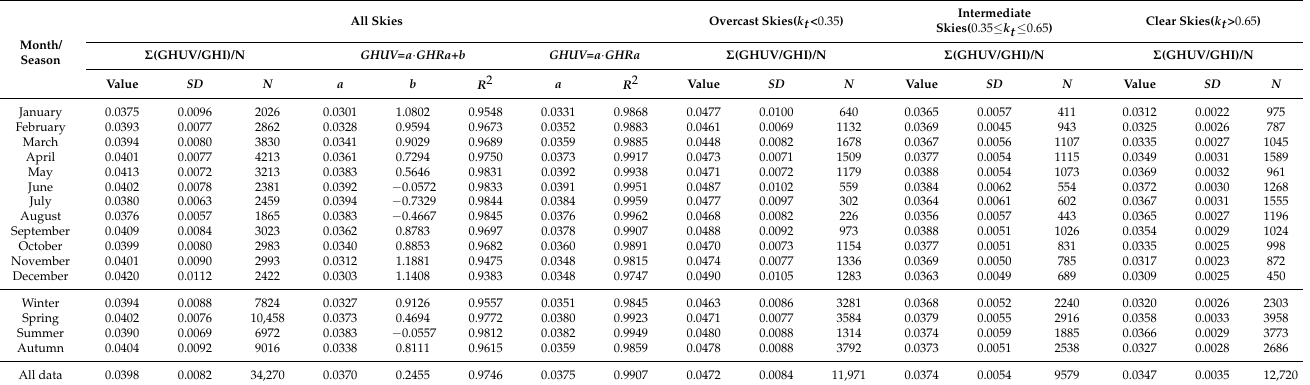
Table 7. Monthly, seasonal, and total averages of the GHUV/GHI ratio, number of 10 min values (N) and standard deviations (SD) under different sky conditions, together with the slope (a), offset (b), and R 2 values of the linear regressions GHUV = a · GHI + b and GHUV = a · GHI .